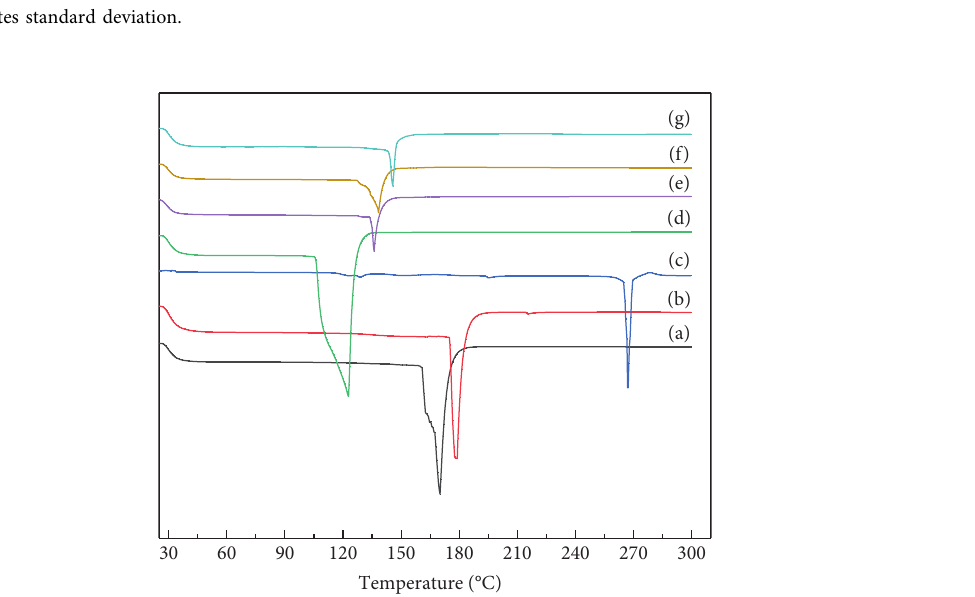
Figure 2: DSC analysis of the thermal properties of each component and the mixed emulsions. DSC thermograms of (a) Ch, (b) SA, (c) DMY, (d) Ch-SA, (e) 1 MIC DMY, (f) 1 MIC DMY, and (g) 1 MIC DMY.